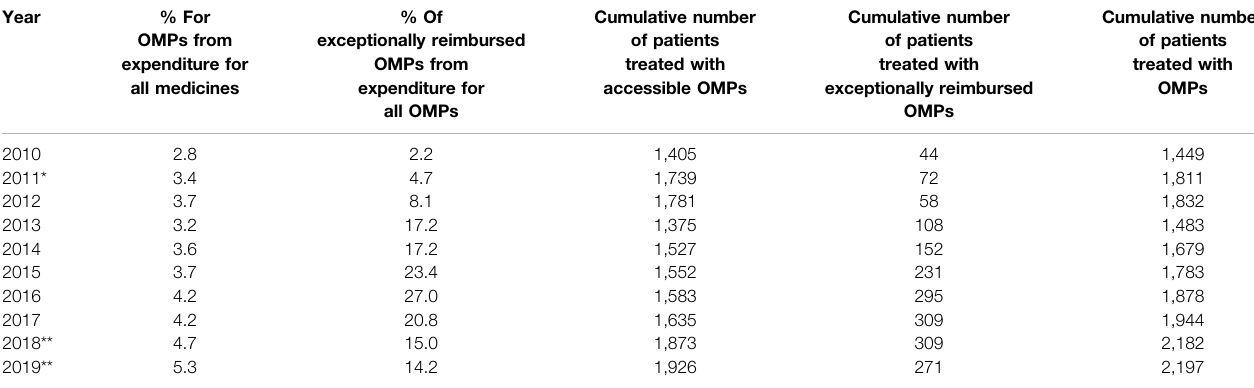
TABLE 1 | Trends in expenditure for OMPs and cumulative number of rare disease patients treated with OMPs per year.